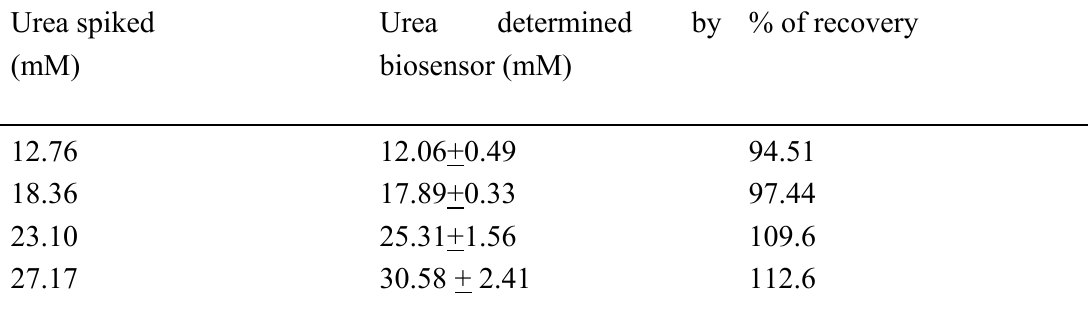
Table 3. The recovery of urea from spiked urine samples based on urea biosensor determination (n =